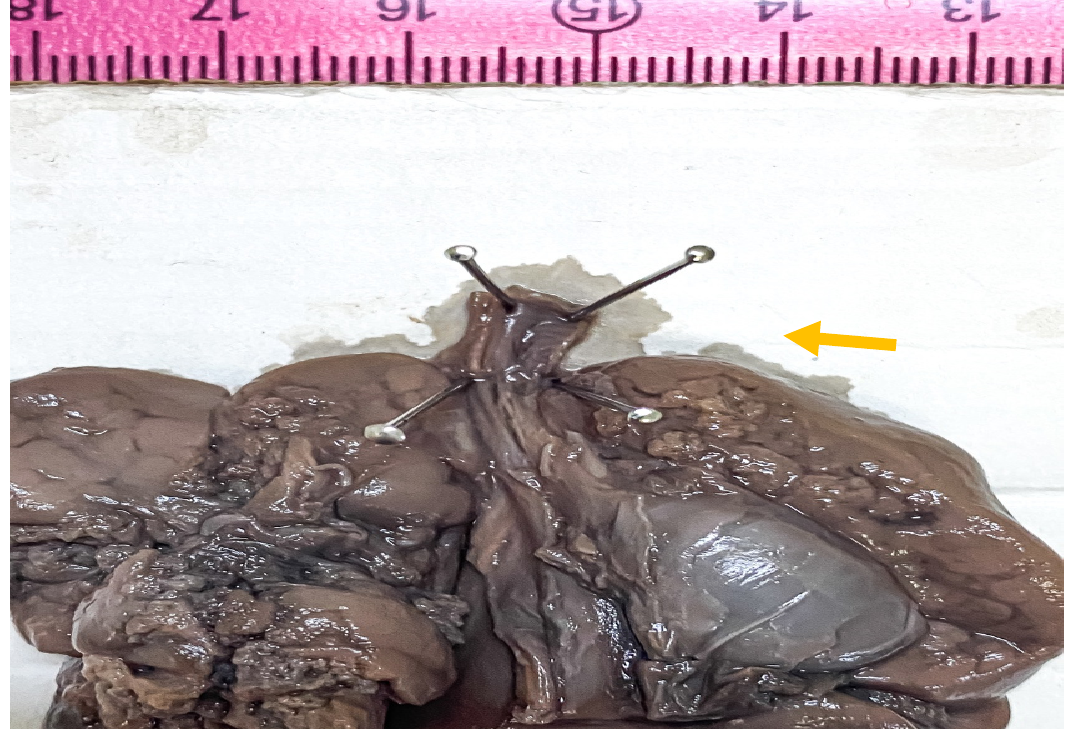
Figure 4. Gross aspect of the dissected cardiothoracic autopsy specimen in anterior view, showing opened distal trachea at the atretic level (black arrow). No bronchoesophageal fistula was detected.